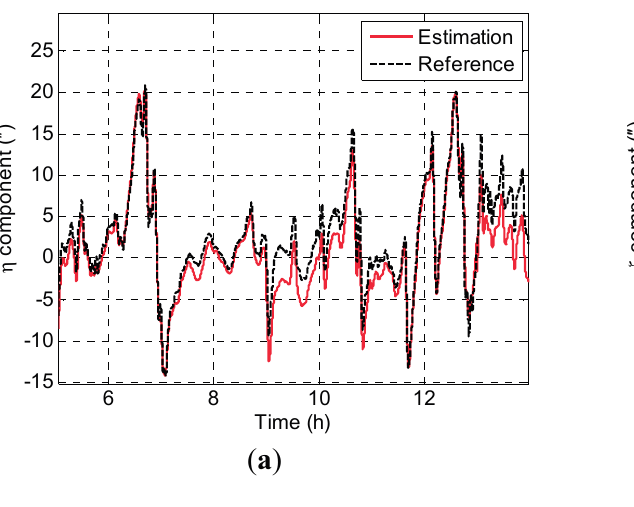
Figure 7. ( a ) Estimation result of η ; ( b ) estimation result of ξ